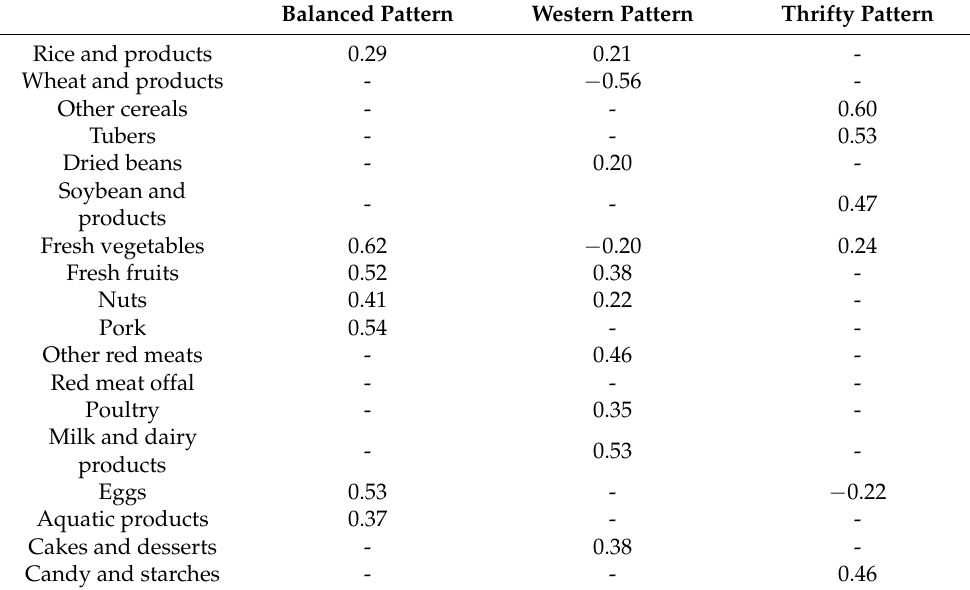
Table 2. Factor loadings for dietary patterns among older participants living in North China